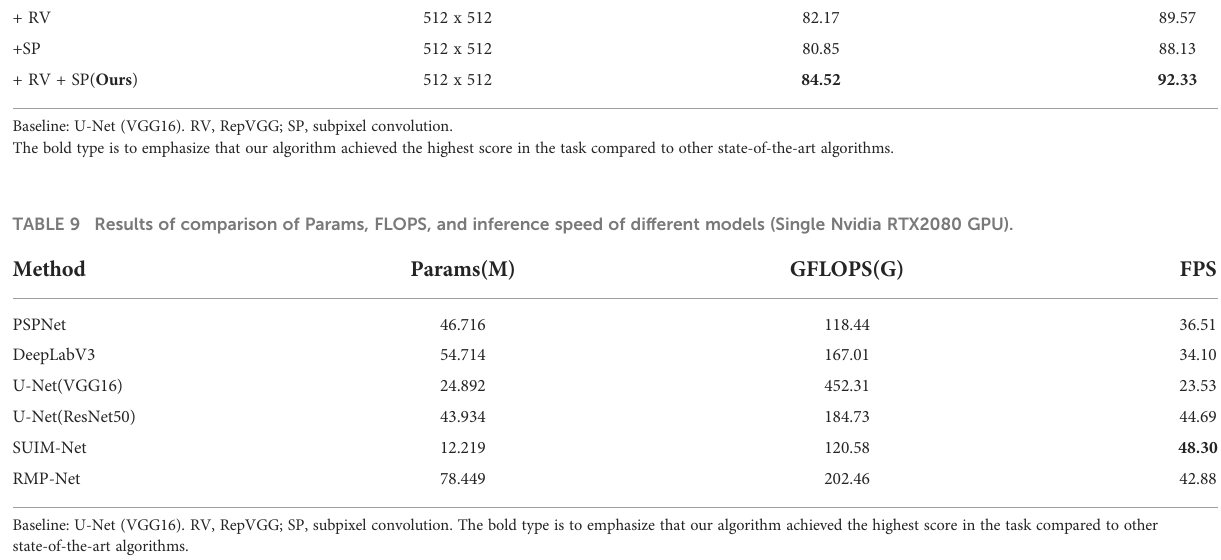
Baseline: U-Net (VGG16). RV, RepVGG; SP, subpixel convolution. The bold type is to emphasize that our algorithm achieved the highest score in the task compared to other state-of-the-art algorithms.